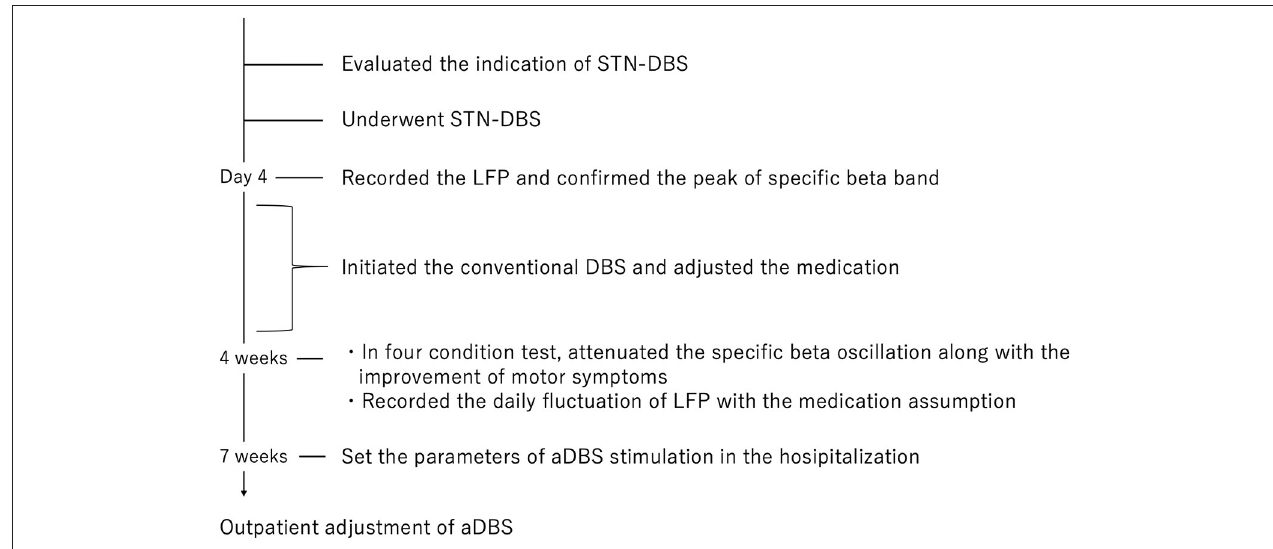
FIGURE 3 | Clinical course of the